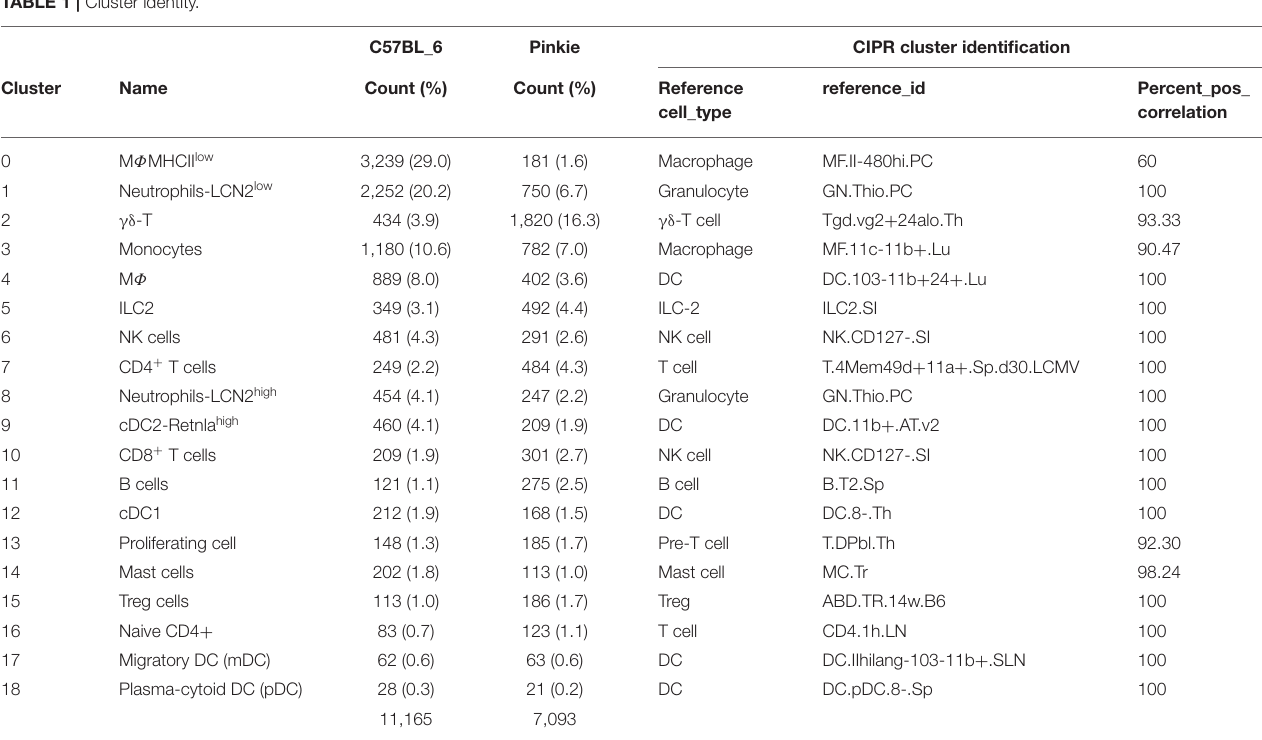
FIGURE 2 | (B) UMAP comparing conjunctival immune cell clusters obtained by scRNA seq of CD45 + cells obtained from 8 mice female C57BL/6J and 8 Pinkie age 16 weeks. The percentage of the cells in each cluster is shown in parentheses and the cell count and percentage for clusters are provided in Table 1 . (C) Heatmap of the top 50 differentially expressed genes in C57BL/6 and Pinkie conjunctival immune cells. Color of the heatmap based on the natural log of the normalized RNA expression; (D) Violin plots showing expression of IL-17a with expression in each cluster in the plots to the right. (E) Violin plots of γδ T cell IL-17 signature genes Ltb, Cxcr6 , Rorc , and IL1rf that have significantly higher expression in Pinkie vs. C57BL/6 (B6). **** p < 0.0001.